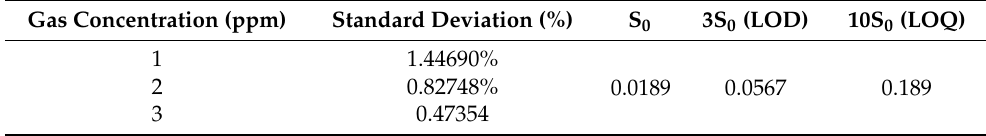
Figure 7. Standard deviation diagram for each concentration. Table 2. Limit of detection (LOD) and limit of quantification (LOQ).